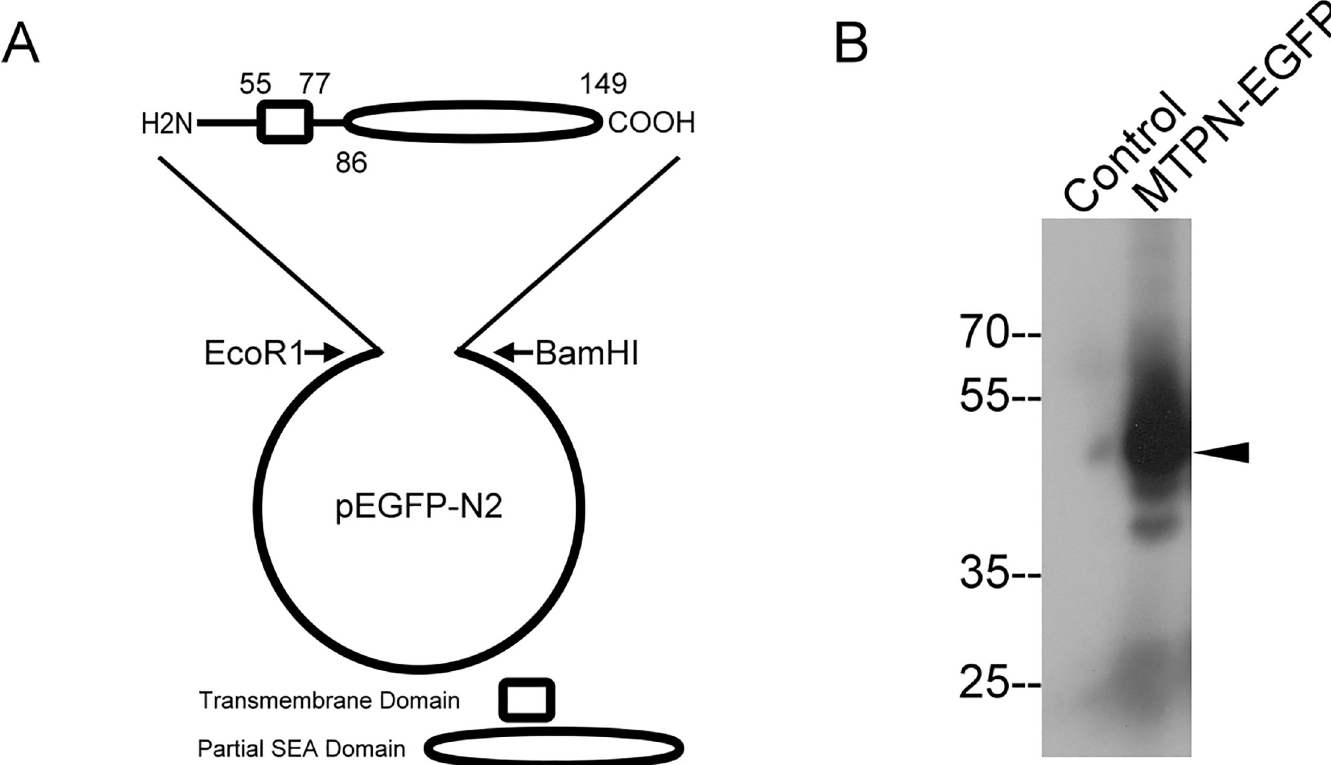
Fig 1. Schematic diagram and expression of the matriptase N-terminal fragment-green fluorescent protein (EGFP) fusion protein. A. The matriptase N-terminal fragment containing the short cytoplasmic domain, transmembrane domain (aa 55–77), and half of the SEA domain (aa 86–149) was inserted into pEGFP expression vector via EcoR1 and BamH1 sites. B. This construct, named MTPN-EGFP, was transiently expressed in HEK293T cells. Lysates prepared from the HEK293T parental cells as a negative control (Control) and from MTPN-EGFP-expressing (MTPN-EGFP) HEK293T cells were analyzed by immunoblot analysis using the matriptase mAb PS6 to identify the matriptase N-terminal fragment-EGFP fusion protein. The fusion protein was identified as a band at the predicted molecular mass of approximately 50-kDa.